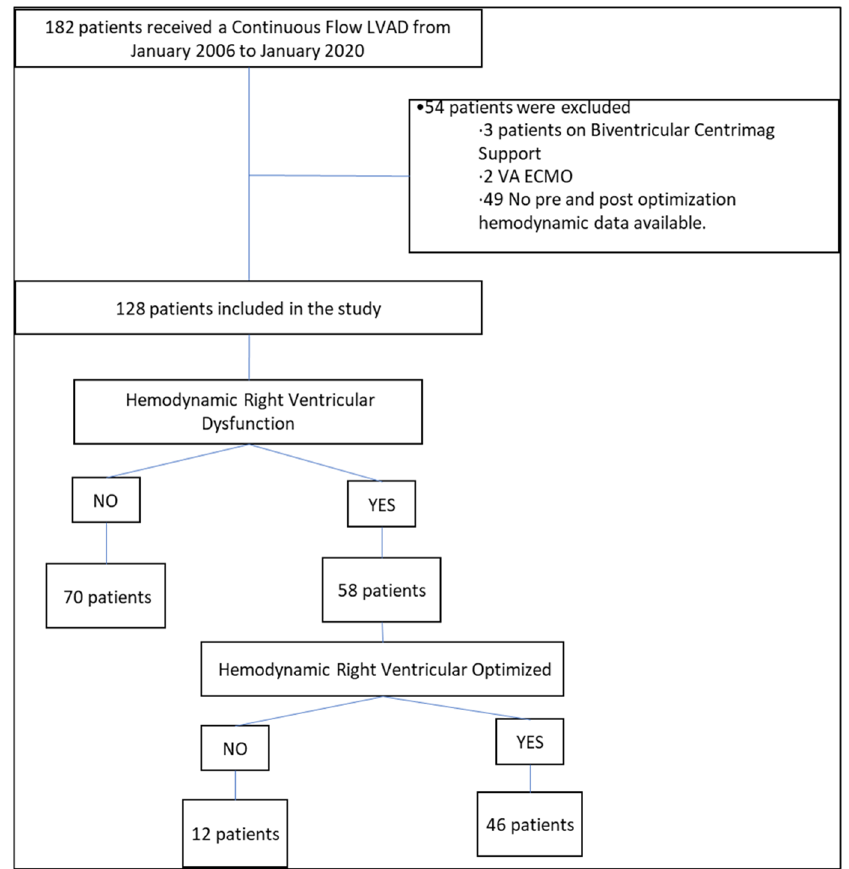
Figure 1. Flow diagram of included patients.